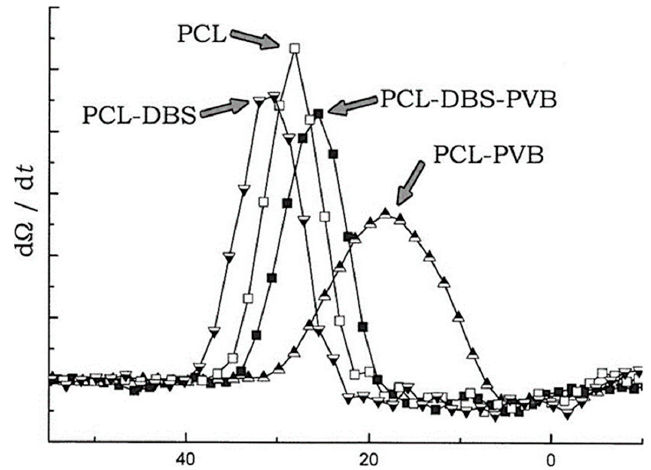
Figure 5. Plots of the derivative of the invariant against the temperature of measurements for each of the four materials considered in this work during the crystallisation stage of the processing cycle described in the text. The uncertainties associated with each data point are horizontally ± 1 ◦ C, vertically 2% of the vertical range.